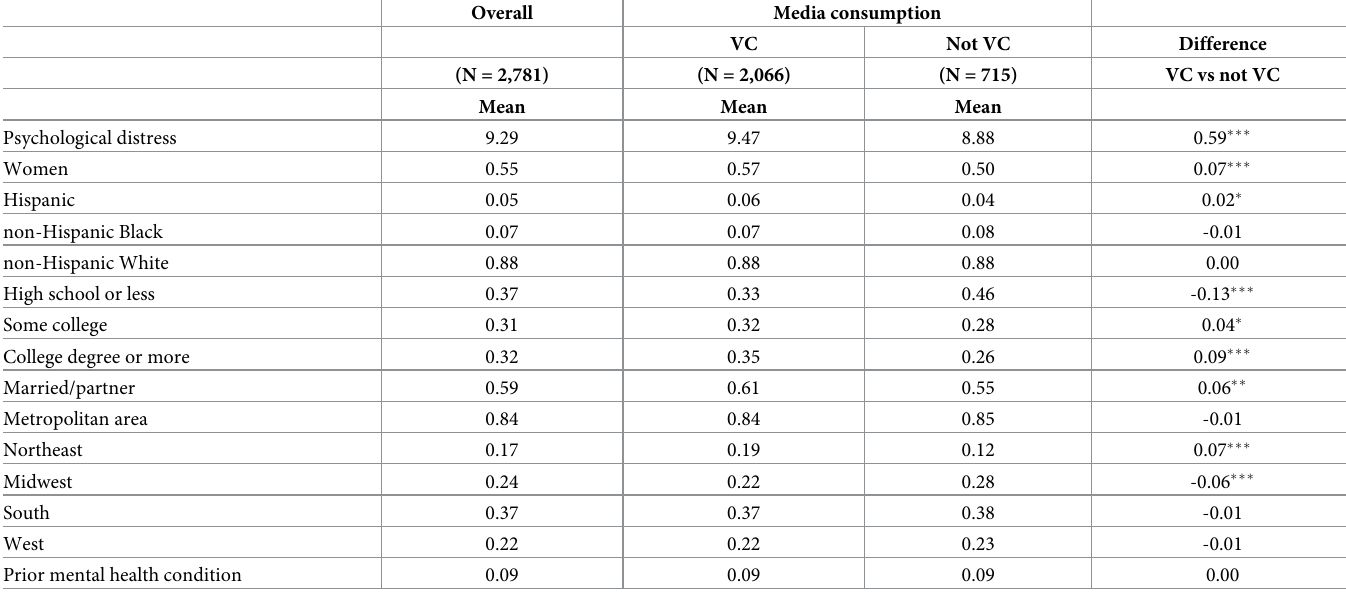
Table 1. Descriptive statistics overall and by COVID-19 media